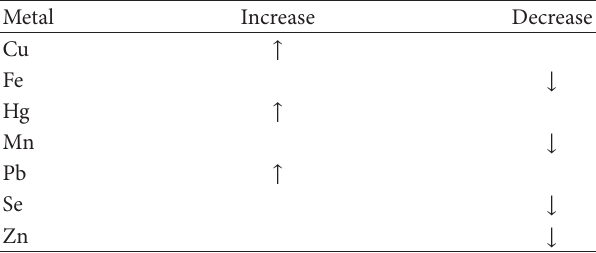
Table 2: Biometal profile seen in many ASD patients [3] derived from measurements of hair and serum